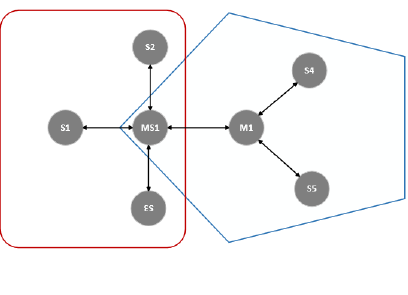
Figure 4. MRT-BLE